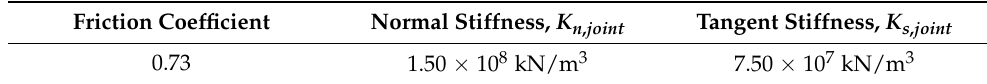
Table 3. Interaction